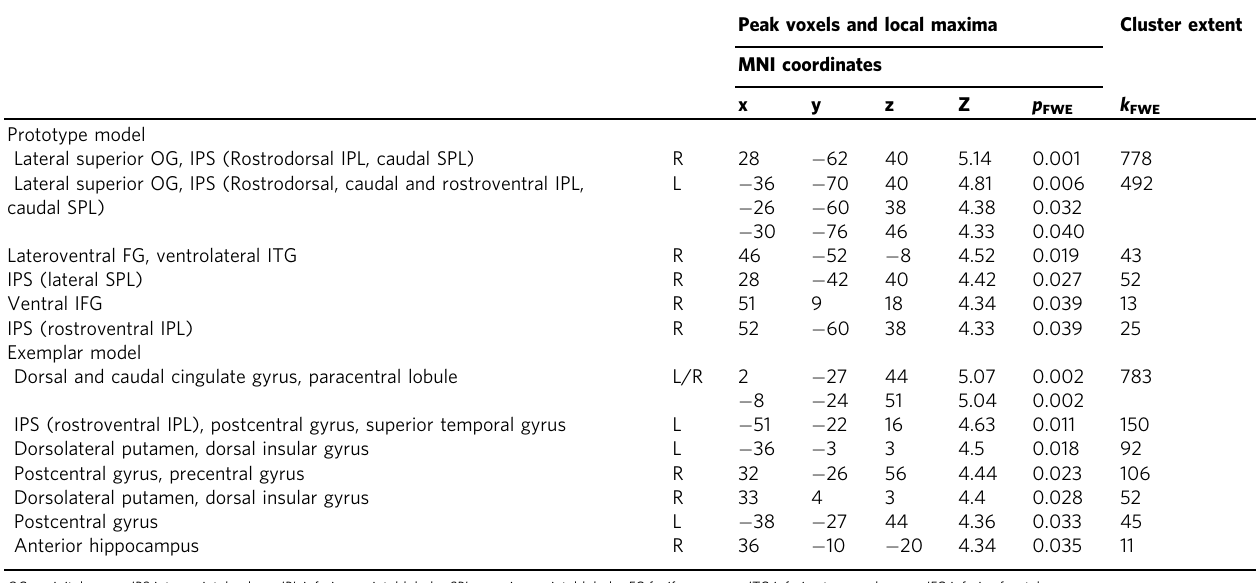
Table 2 Localisation of multivariate prototype and exemplar neural representations.